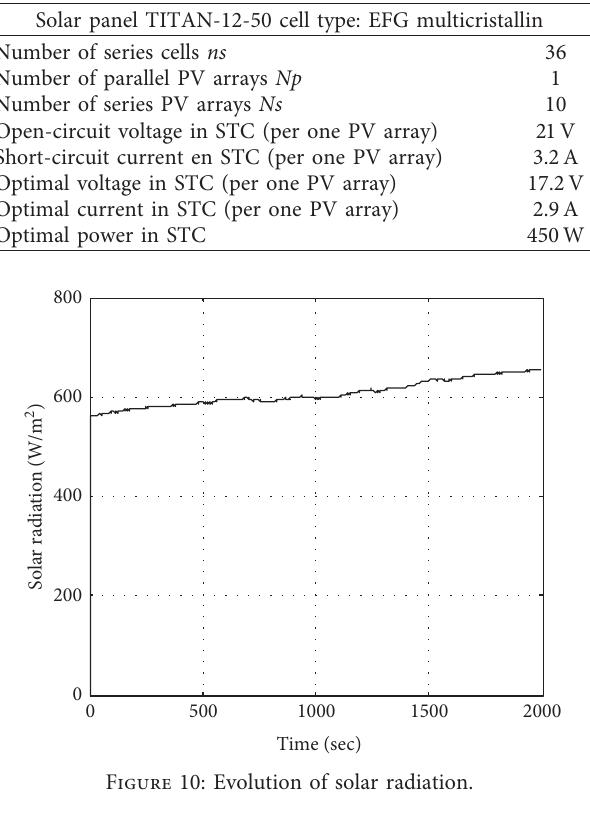
Table 1: Parameters of the PV generator used in simulation.